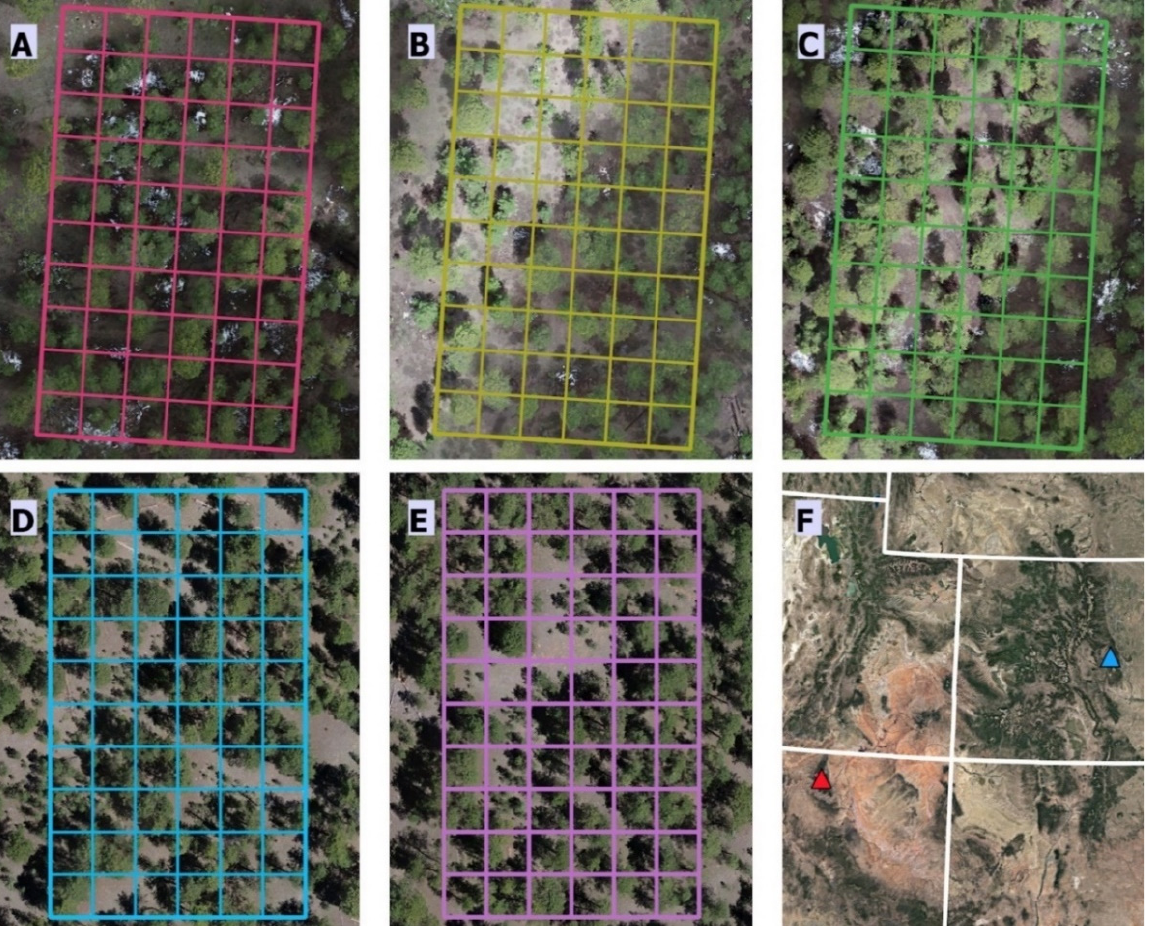
Figure 1. Five 60 m × 100 m study areas at the Kaibab National Forest in Northern Arizona (KNF1: ( A ), KNF2: ( B ), KNF3: ( C )) and Manitou Experimental Forest in Central Colorado (MEF1: ( D ), MEF2: ( E )), with the location of KNF study area (red) and MEF study area (blue) displayed in panel ( F ). Each study area was divided into sixty 10 m × 10 m plots.